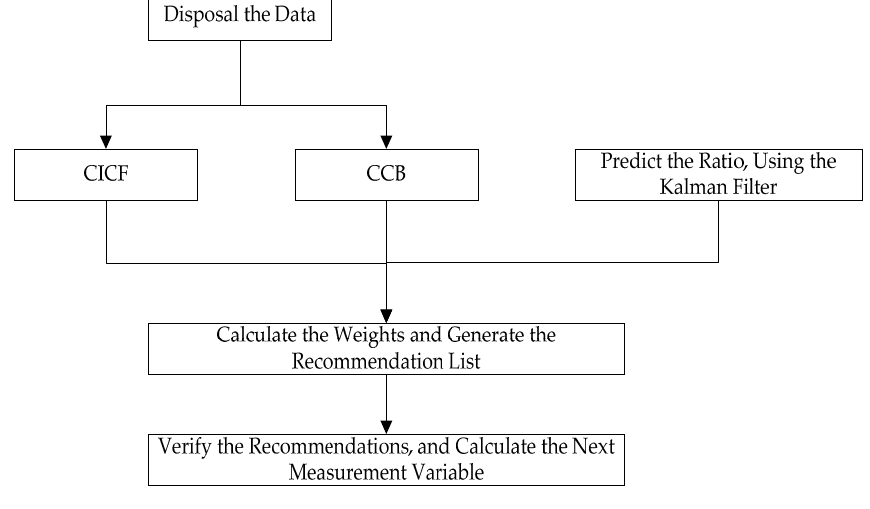
Figure 6. The WHRA-KF process.